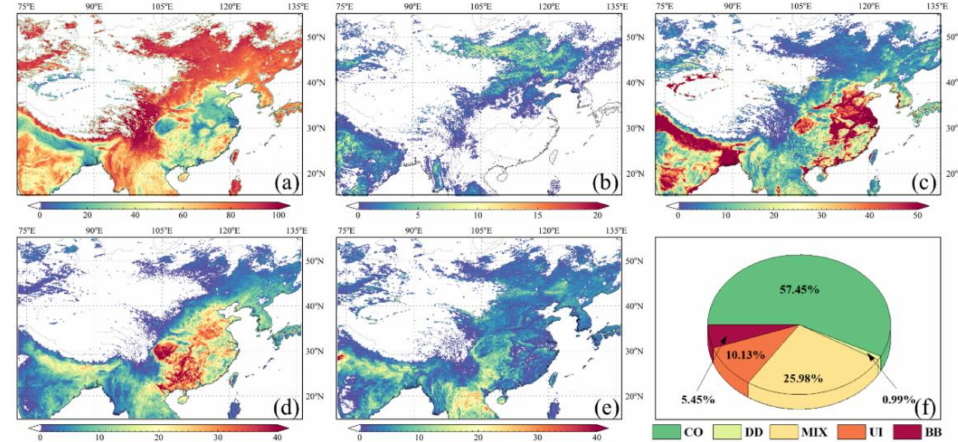
Figure 8. Spatial distribution of ( a ) CO, ( b ) DD, ( c ) MIX, ( d ) UI, and ( e ) BB aerosol proportion; ( f ) the total proportion of five types of aerosols based on MODIS